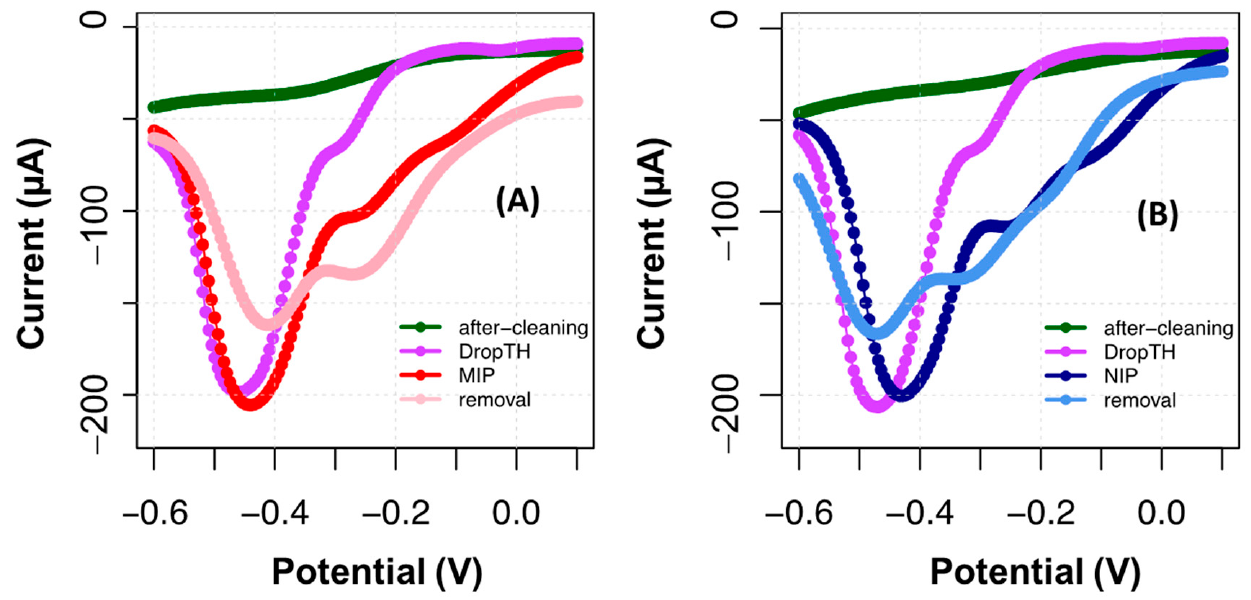
Figure 5. DPV voltammogram of C-SPE after cleaning of surface (green), drop-casting TH (violet), electropolymerizing TH with or without CA 19-9 (red, MIP, and blue, NIP), and removing the template (coral, MIP, and light-blue, NIP). ( A ) represents the MIP assembly and ( B ) the NIP assembly.